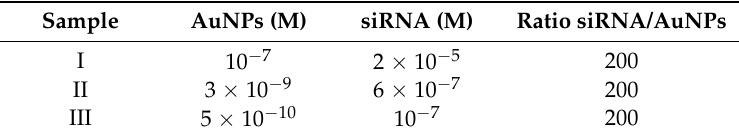
Table 1. The concentration of the components for core preparation.